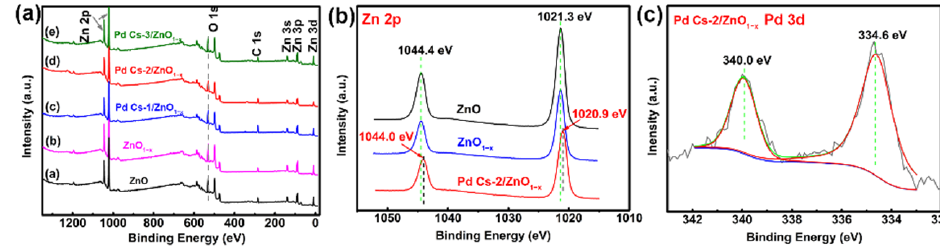
Figure 7. ( a ) XPS survey scan for five gas-sensing materials, ( b ) Zn 2p spectrum of ZnO, ZnO 1−x and Pd Cs-2/ZnO 1 − x , and ( c ) Pd 3d spectrum of Pd Cs-2/ZnO 1 − x , Pd Cs-2/ZnO 1−x , and ( c ) Pd 3d spectrum of Pd Cs-2/ZnO 1−x , respectively.